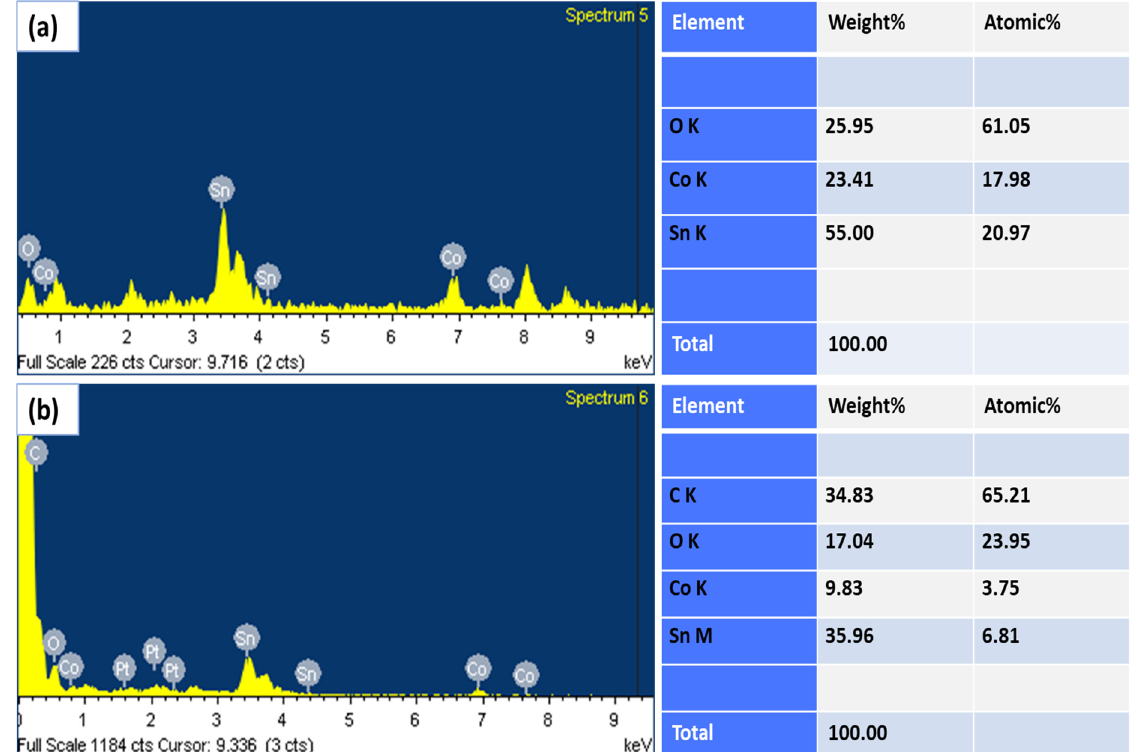
Figure 2. EDX spectra of Co-SnO 2 nanomaterial ( a ) and GL/Co-SnO 2 hydrogel nanocomposite material ( b ).